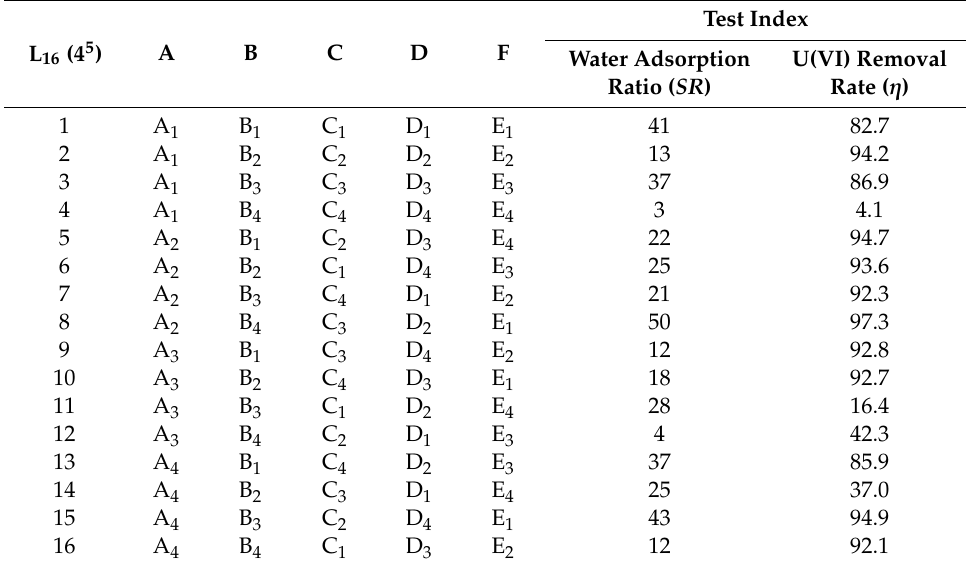
Table 4. Results of the 5-variable 4-level orthogonal experiment.